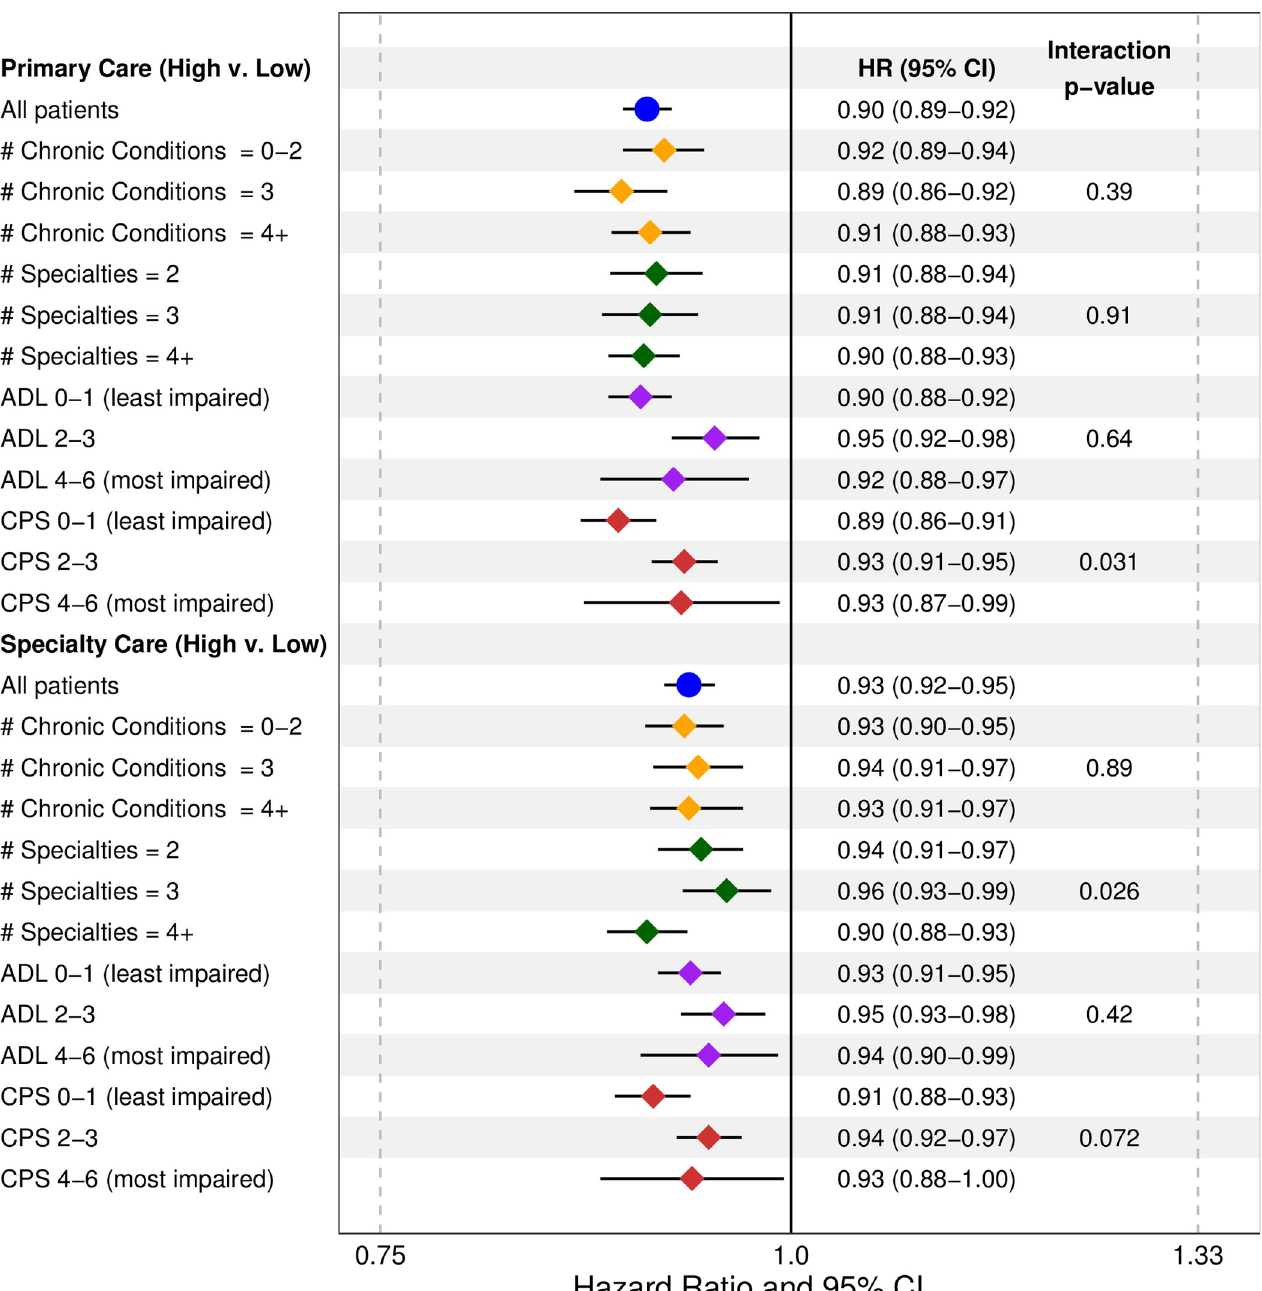
Fig 2. Associations between continuity of care and risk of an emergency department visit across effect modifiers.